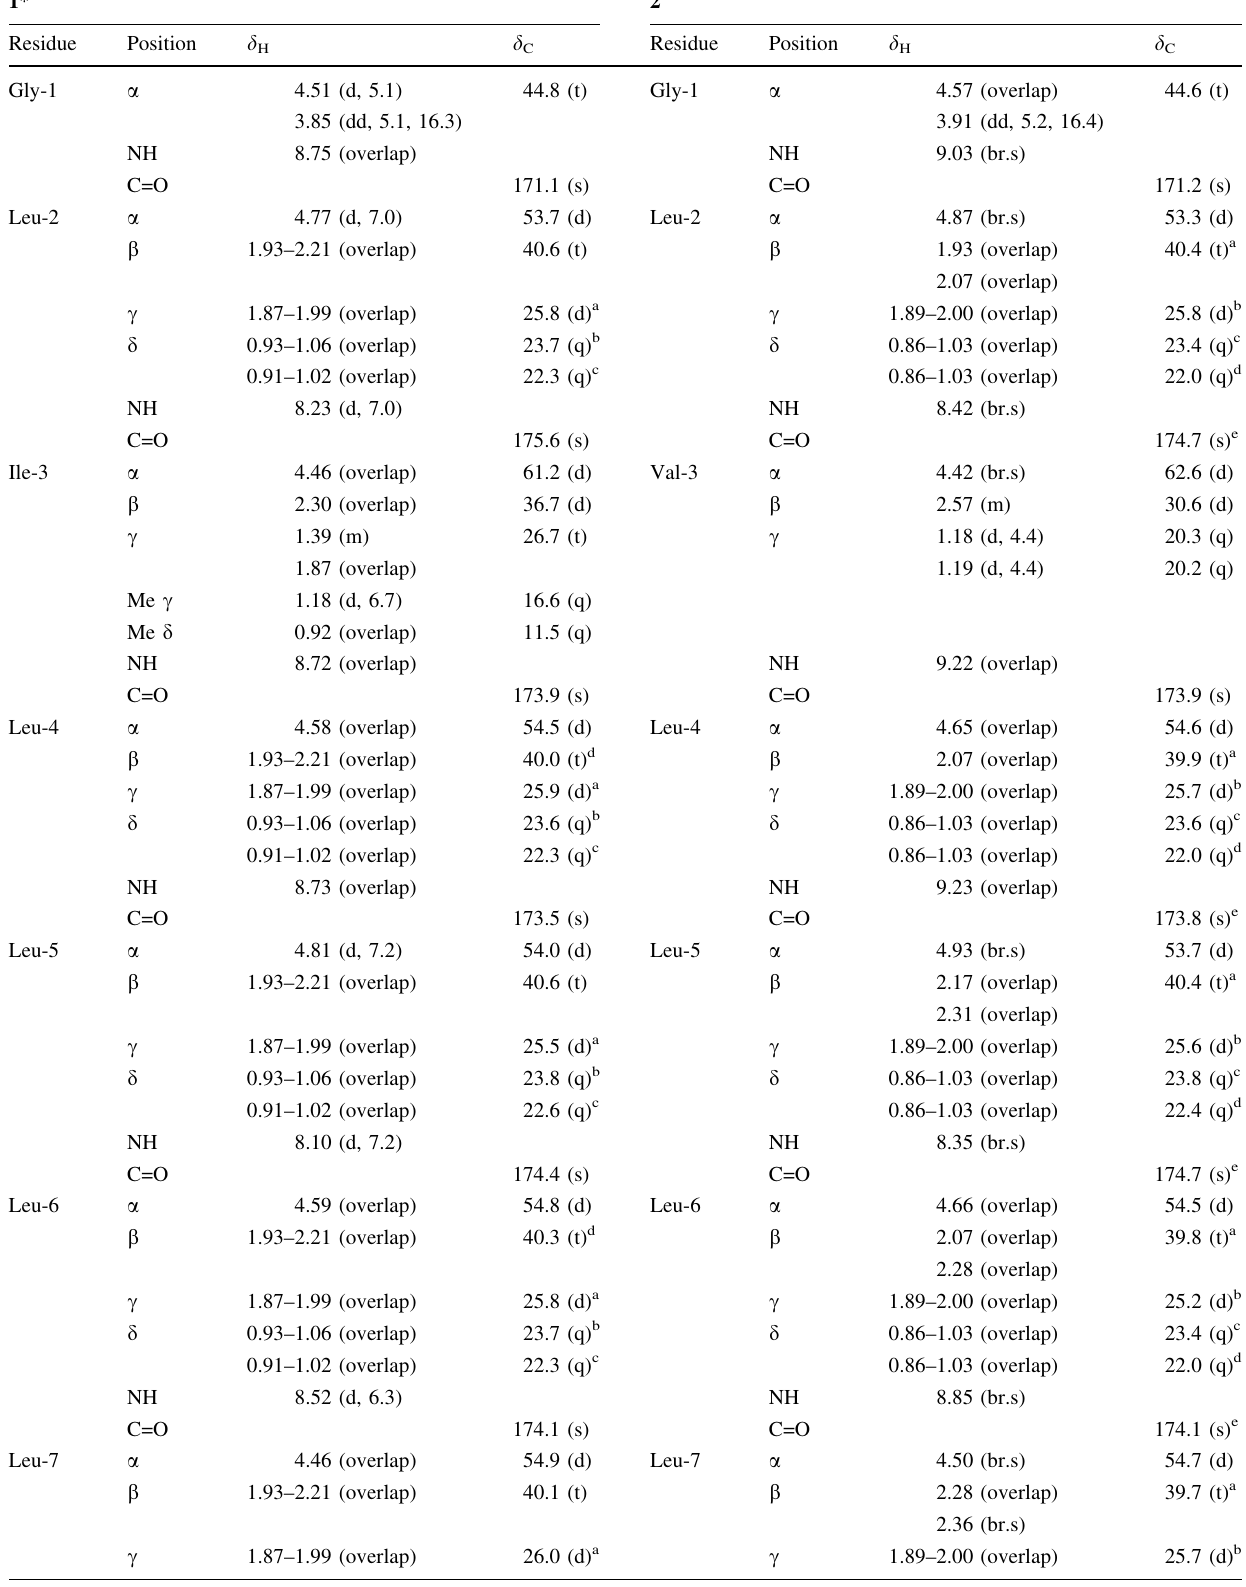
Table 1 NMR data of compounds 1 and